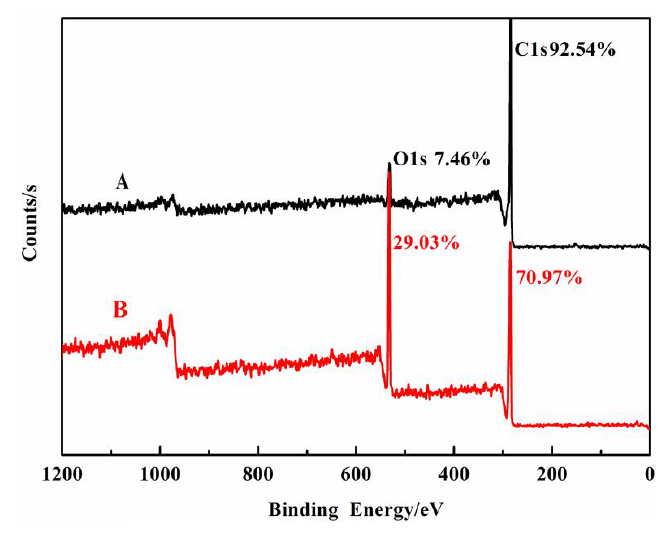
Figure 3. XPS wide scan spectra of (A) untreated CF and (B) PMMA-g-CF. Table 1. Contents of correlative functional groups on untreated CF and PMMA-g-CF surfaces.